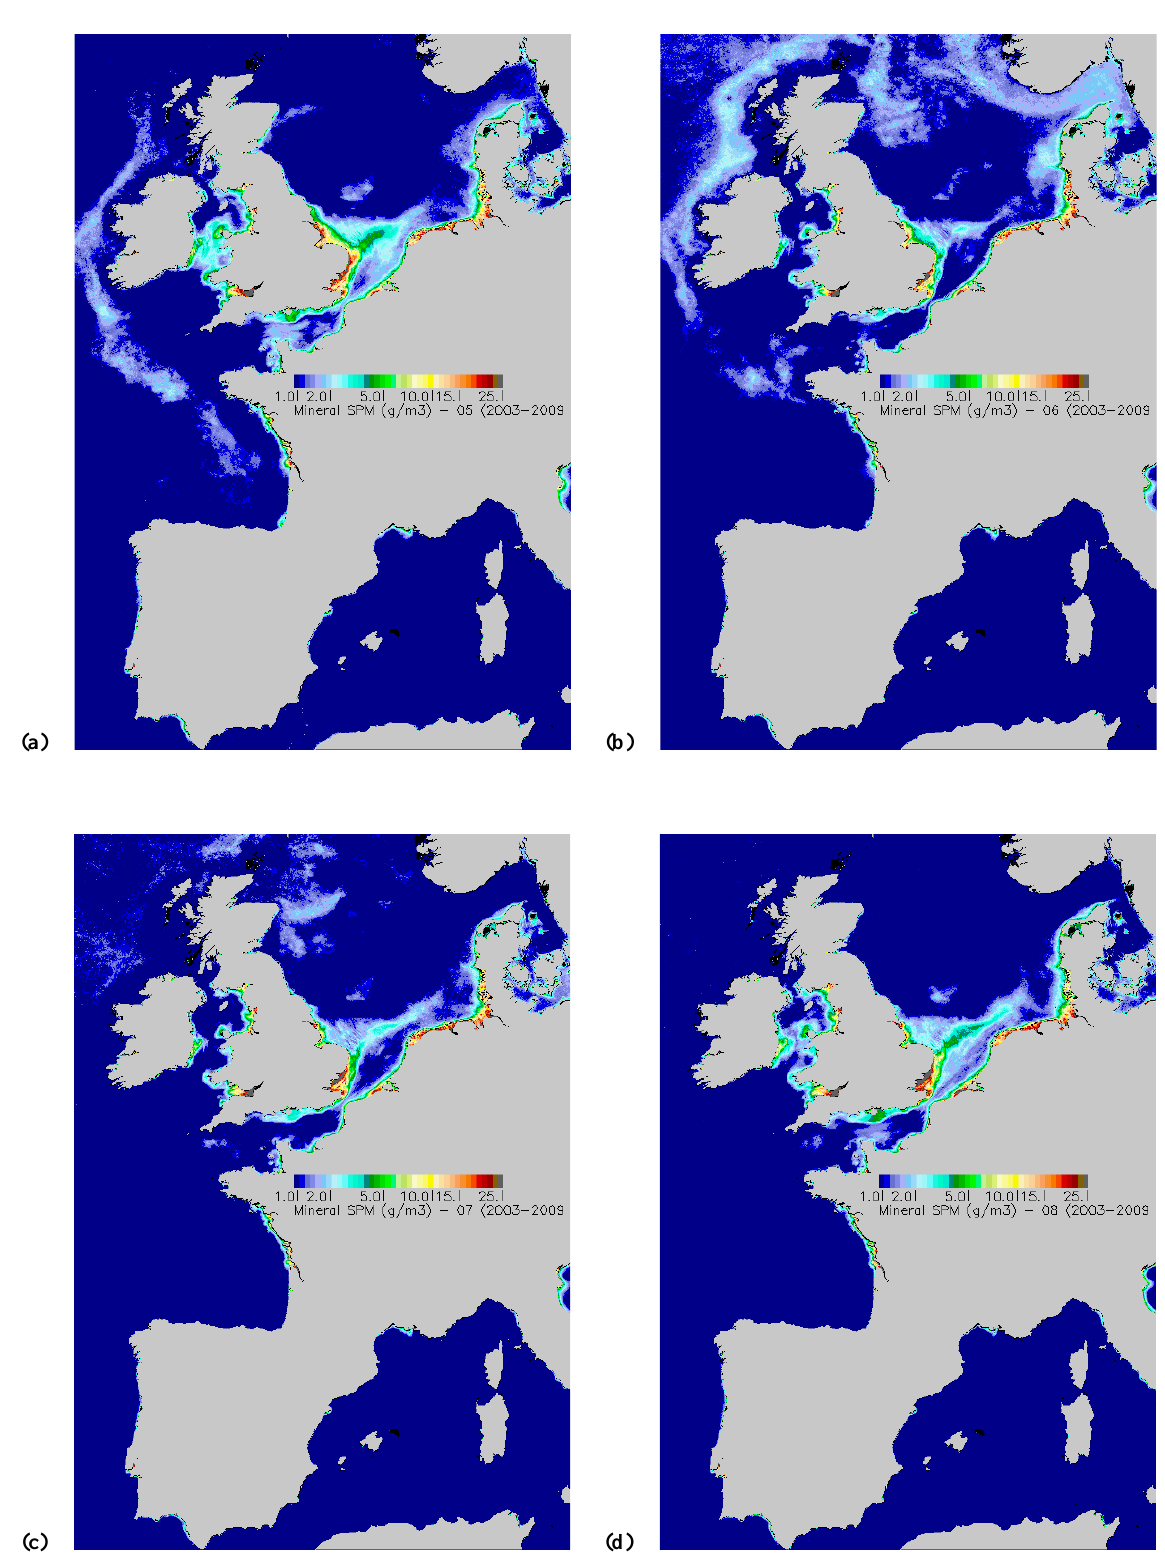
Fig. B2. Monthly non-algal SPM in May (a) , June (b) , July (c) and August (d)